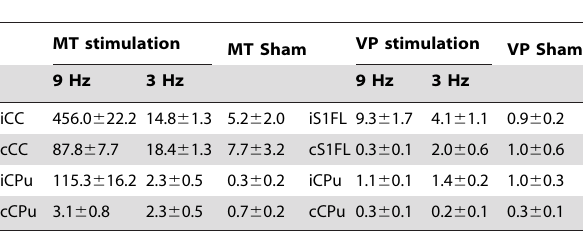
Table 1. c-Fos cells after MT and VP